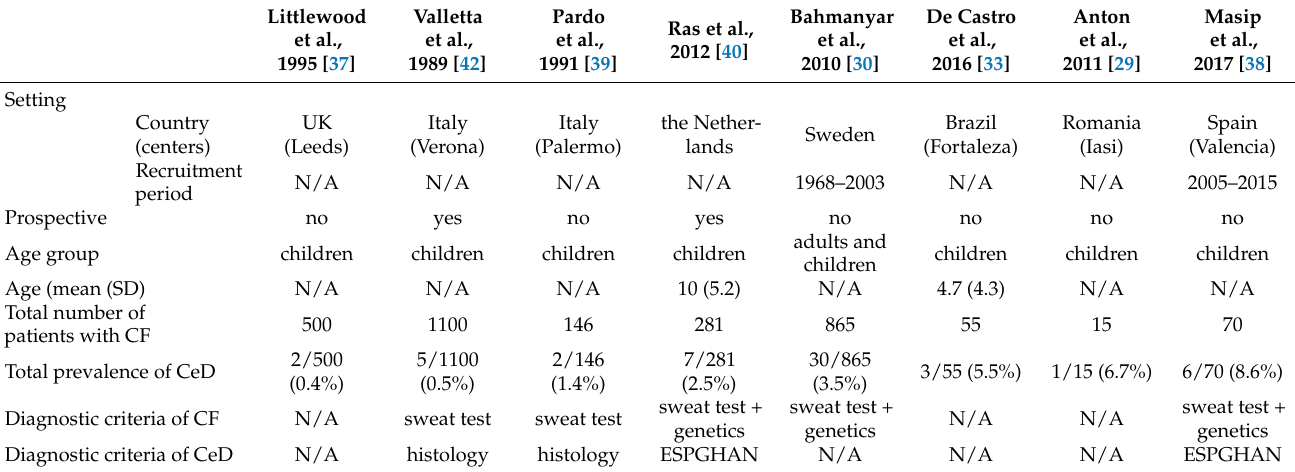
Table 2. CeD prevalence from non-consecutive studies (SD: standard deviation, CF: cystic fibrosis, CeD: celiac disease).